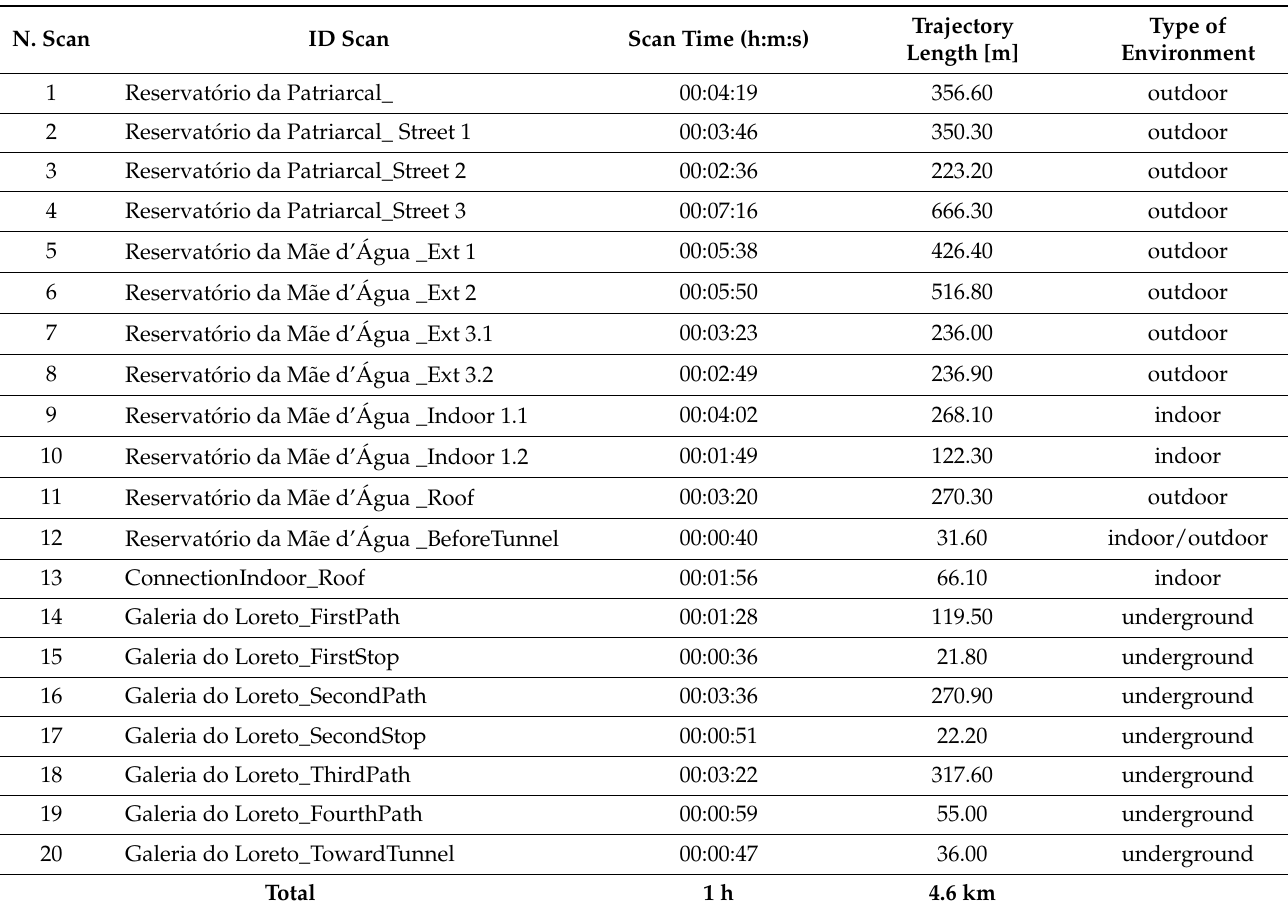
Table 3. Data acquisition parameters.